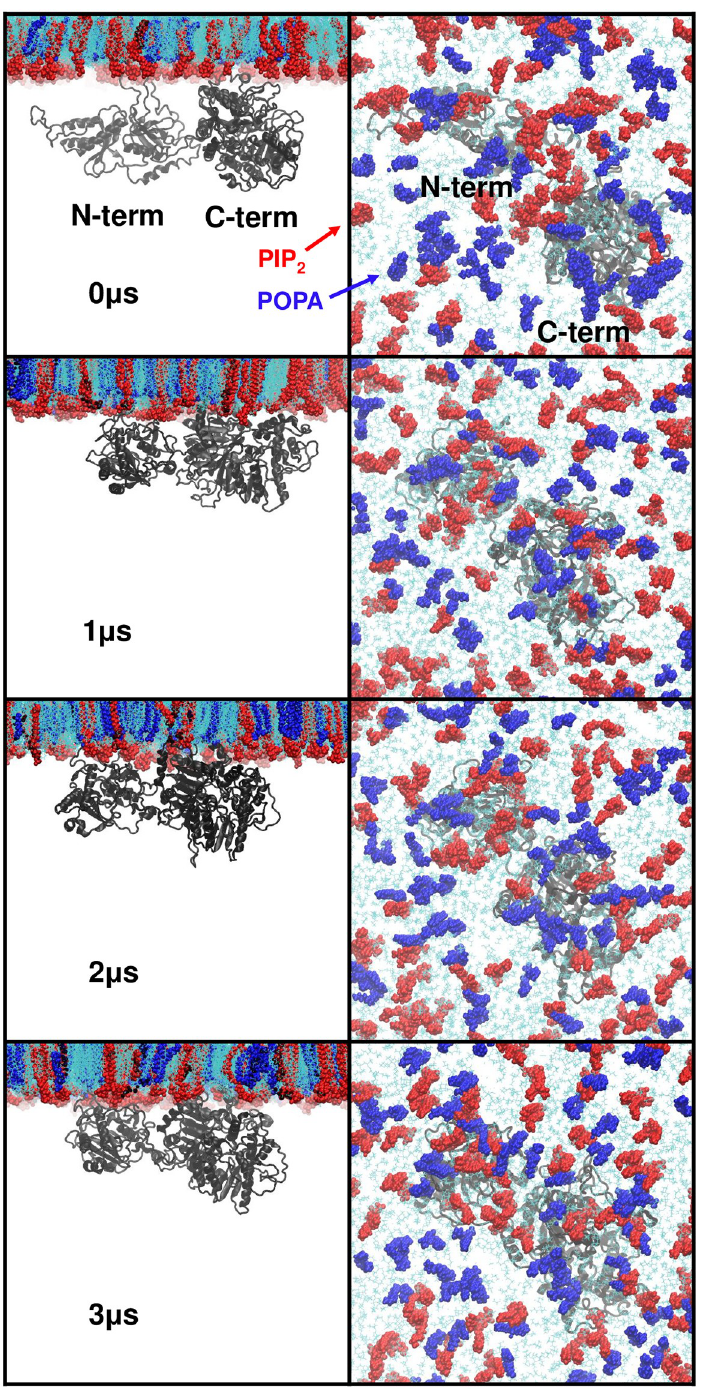
Fig 7. Snapshots of 10% PIP 2 bilayer system (R1). (left) side view at 0, 1, 2, and 3 μ s and (right) corresponding top view. Coloring is as follows: PIP 2 , red; POPA, blue; other lipids, cyan; hPLD, gray.